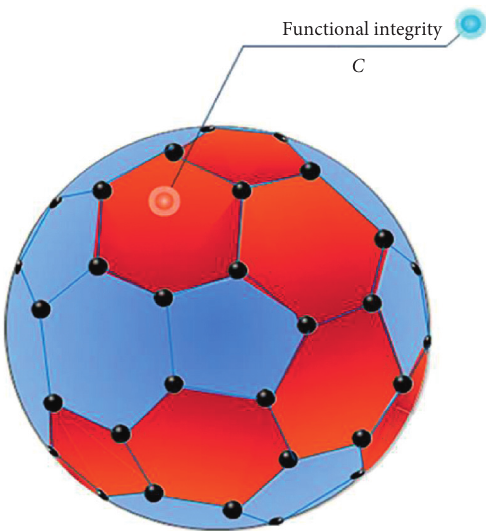
Figure 1: Schematic diagram of functional